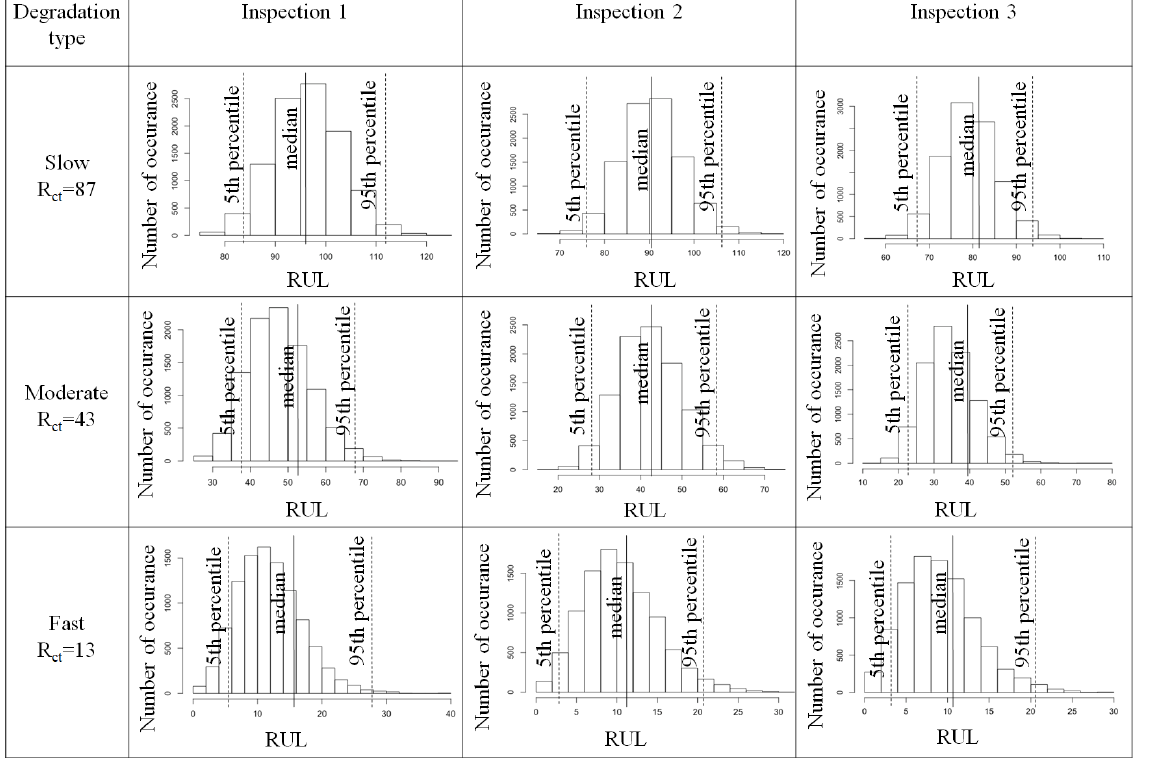
Figure 17. Position of the real crossing time R ct compared to the 5% and 95% percentiles of the RUL histograms for real data with the NN algorithm at different inspection times: Slow, moderate, and